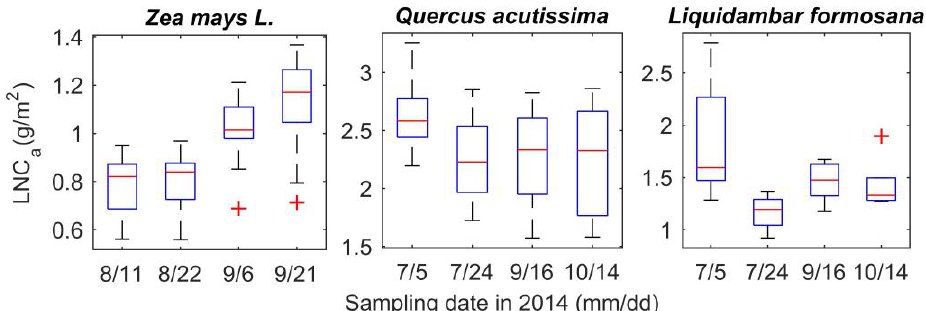
Figure 1. Temporal variations of the area-based LNC for three species. The bottom and top of the box are the first and third quartiles. The band inside the box is the median. The ends of the whiskers represent upper and lower extremes.